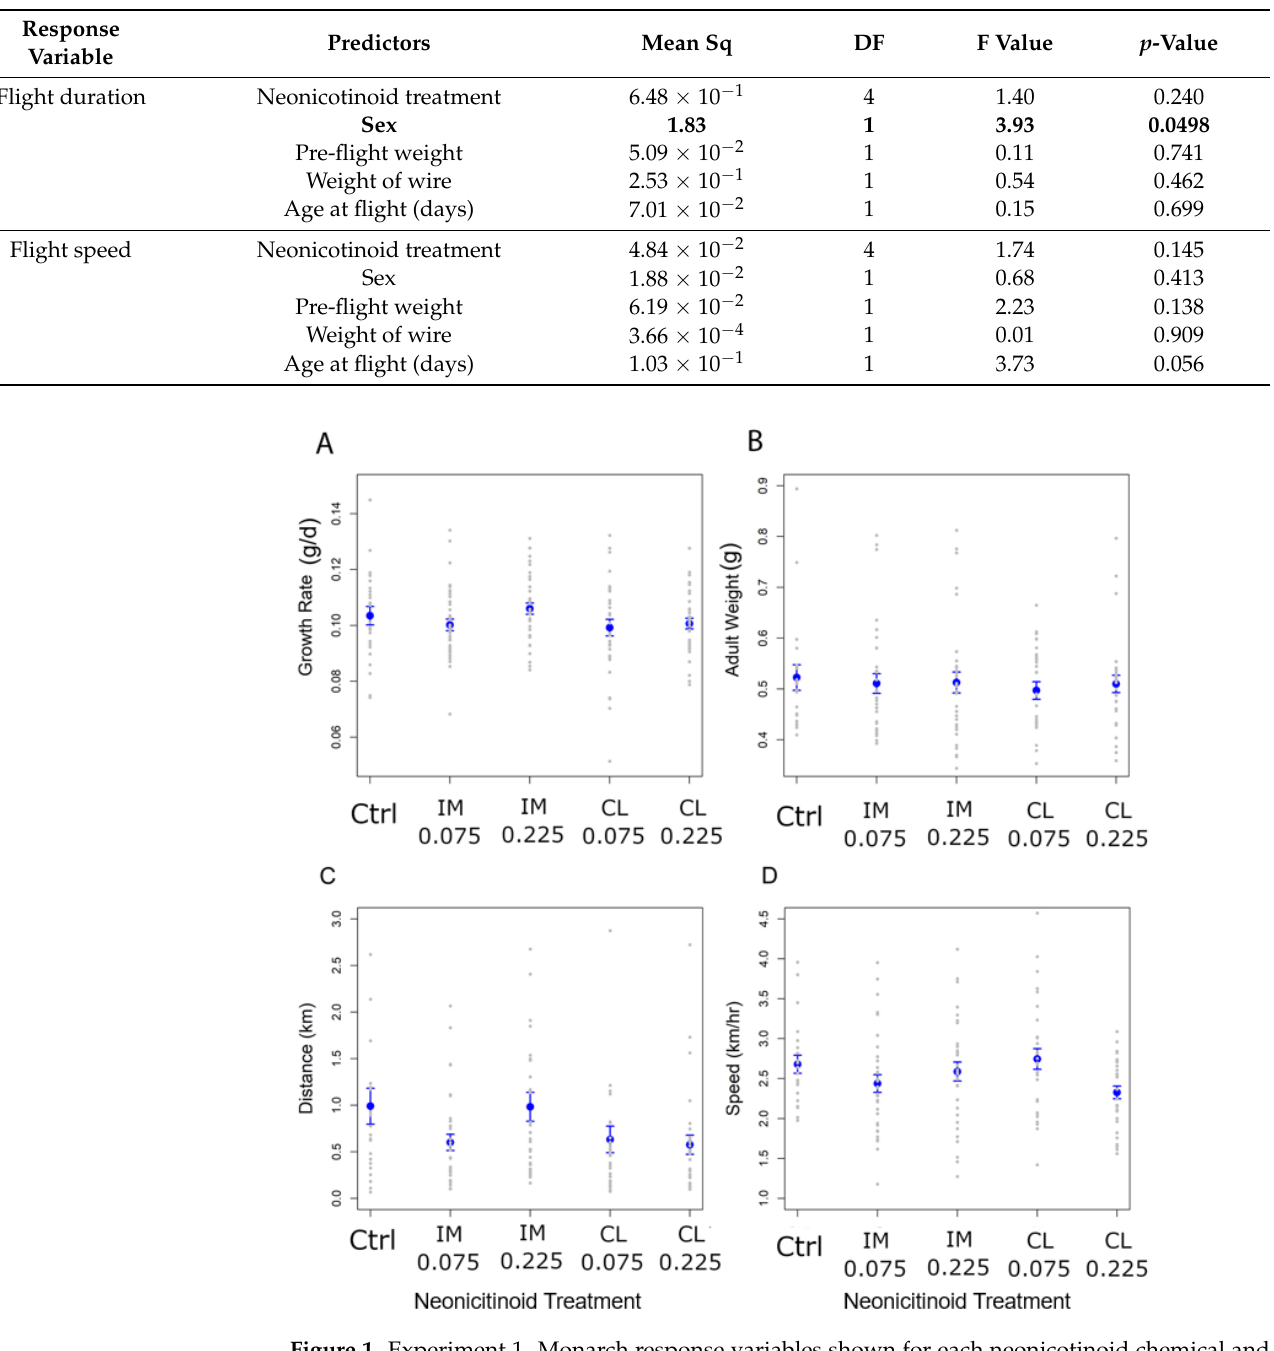
Figure 1. Experiment 1. Monarch response variables shown for each neonicotinoid chemical and dose reared on swamp milkweed. IM = imidacloprid and CL = clothianidin. Numbers under the neonicotinoid treatment indicate the estimated concentration on leaf tissues in ng/g, though realized dose for each treatment was below detection levels (Table 1). Gray dots represent each individual monarch; error bars represent standard errors. ( A ) Larval growth rate (g/d); ( B ) Weight (g) of adult monarchs upon eclosion; ( C ) Flight distance in km (flights were terminated after a maximum of 1 h); ( D ) Flight speed, measured as total distance in km over flight duration in hours.